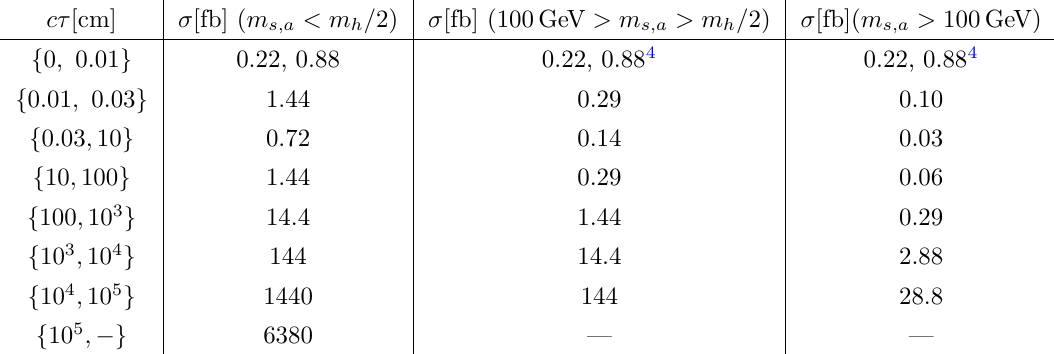
— — Table 1. Bounds on ( h → ss ( aa ) → l + l − + X ) projected to 13 TeV LHC with luminosity L = 139 fb − 1 that are satisfied by all the benchmark scenarios (via on-shell Higgs at different values of mass) with similar kinematic regions studied in [42–45]. The first number in the first row of each column is the bound obtained by searches for 5 leptons [42] which could be applicable to singlet a searches if a decays promptly, while the second number is the bound from Higgs exotic decay [20] to four leptons, applicable to singlet s searches if s decays